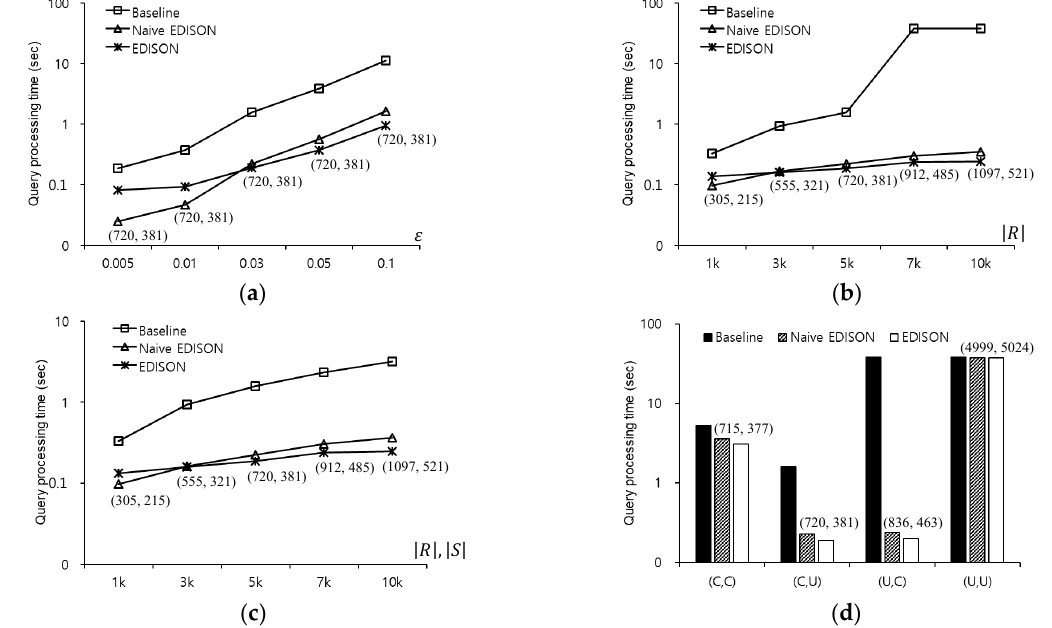
Figure 17. Comparison of the baseline, naive EDISON, and EDISON methods for COL ( a ) varying ε ; ( b ) varying | R | ; ( c ) varying | R | and | S | ; ( d ) varying the distributions of objects.